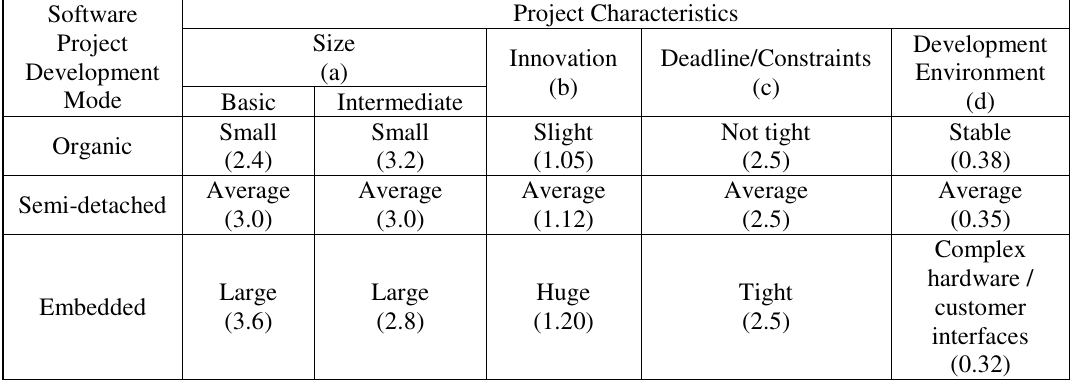
TABLE 2 ． MODES OF DEVELOPMENT AND VALUES OF COEFFICIENTS FOR BASIC AND INTERMEDIATE